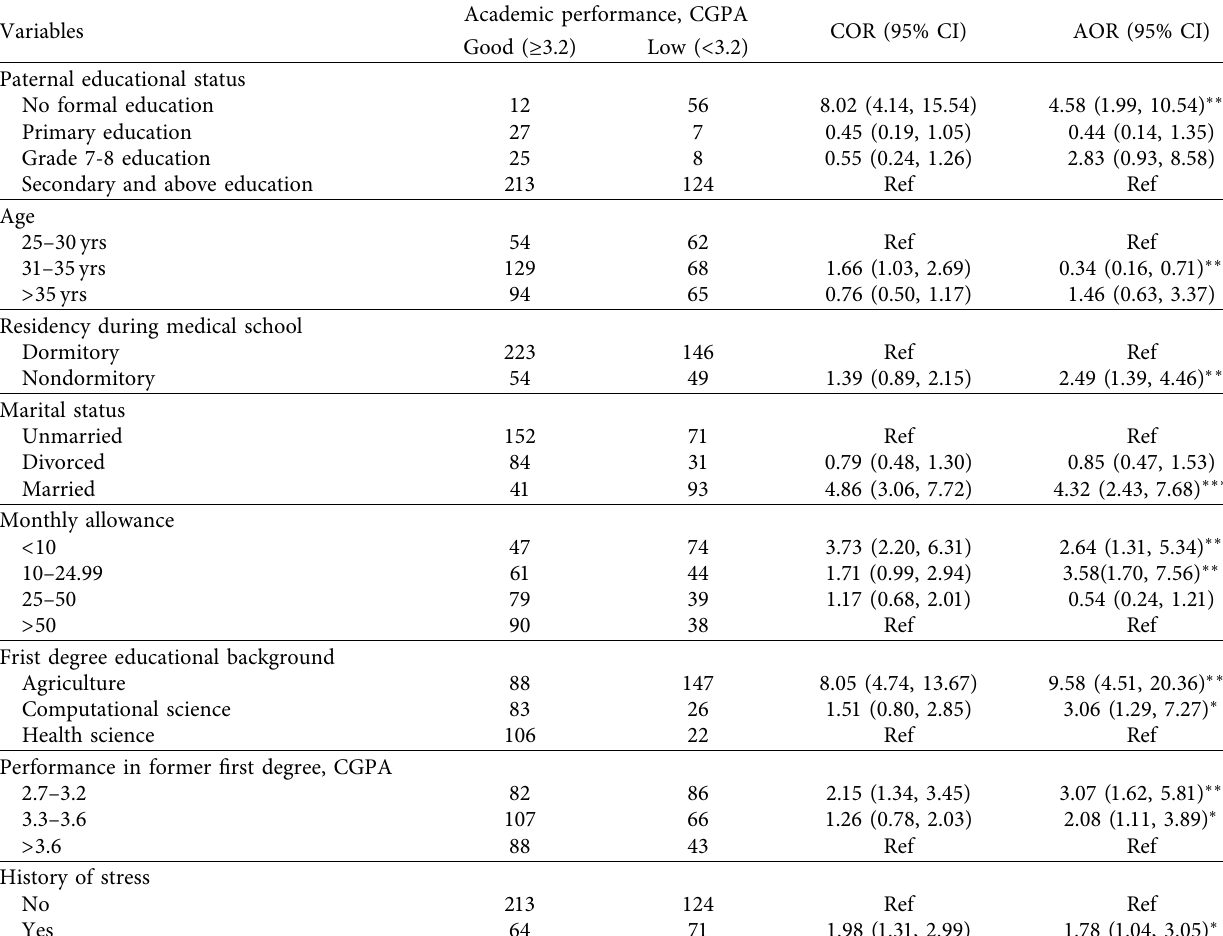
Table 4: Binary and multiple logistic regression analysis of academic performance based on CGPA as a dichotomous variable, for new medical education system students in